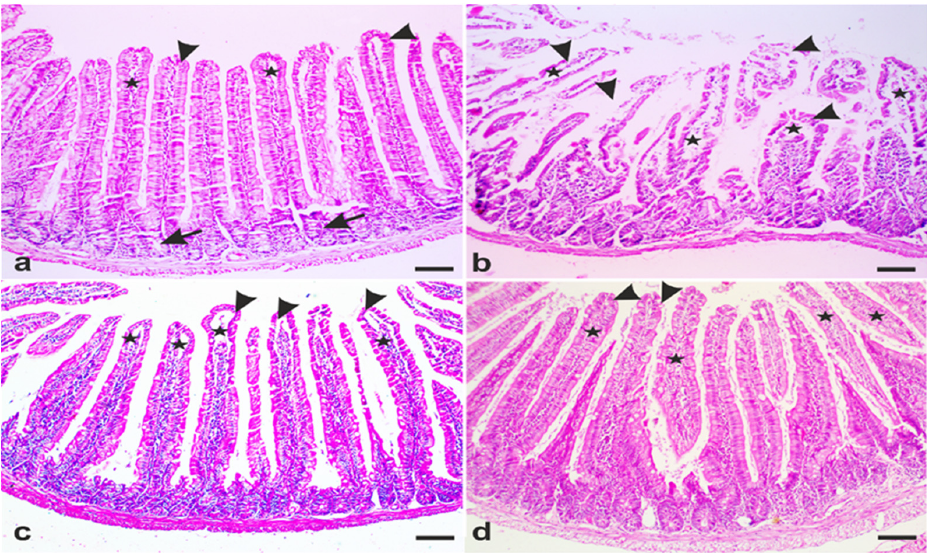
Figure 3. Representative photomicrographs of small intestinal sections from different groups of hamsters stained with hematoxylin and eosin . ( a ) Representative tissue from uninfected animals showing intact villi (arrowheads), crypts (arrows), connective core of the villi (stars). ( b ) Repre- sentative tissue from infected animals showing shortening and disruption of villi (arrowheads) and retraction of the connective tissue core of the villi (stars). ( c ) Representative tissue from in- fected animals that are treated with metronidazole with well-formed mucosal epithelial lining of the villi (arrowheads) and intact villi cores (stars). ( d ) Representative tissue from infected animals that are treated with A. annua extract showing well-formed villi (arrowheads) with regular epithe- lial lining and intact connective tissue core (stars). Scale bars = 100 µm.